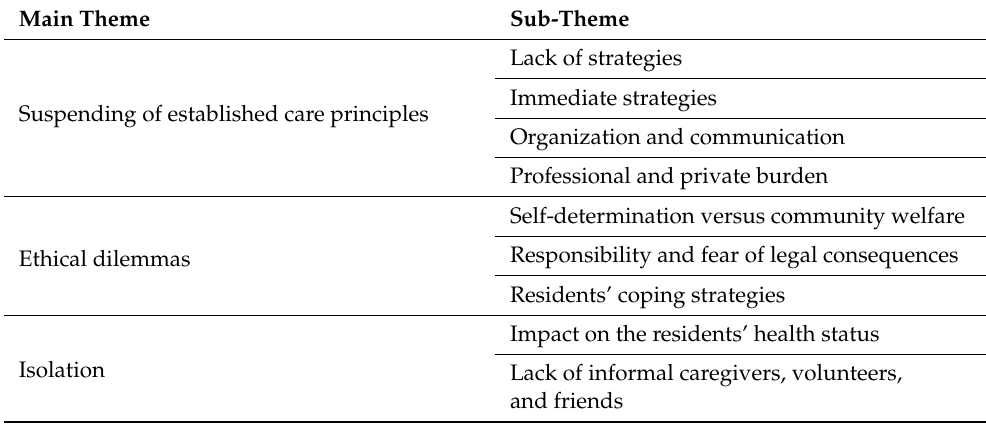
Table 3. Emerging themes and sub-themes from the interviews with residents, care workers, relatives, and